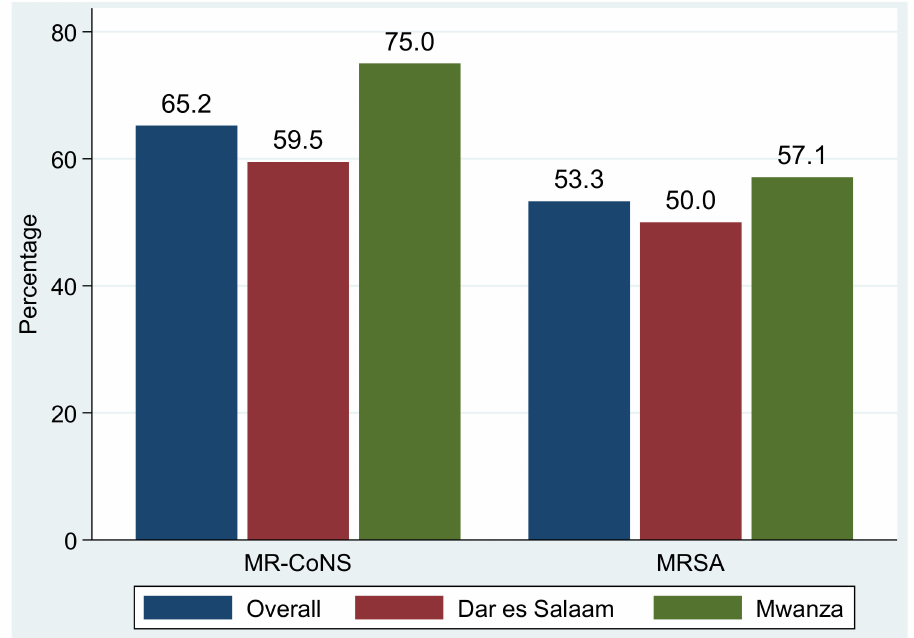
Figure 1. Proportions of methicillin resistance among S. aureus (MRSA) and CoNS (MR-CoNS).